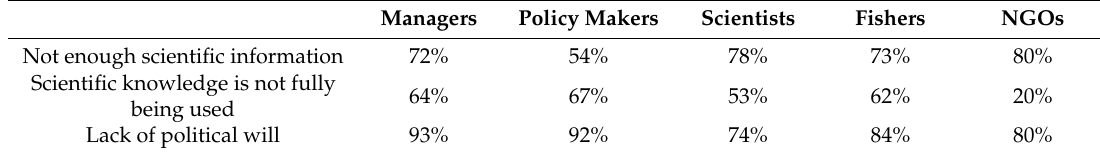
Table 4. Major reasons for why regulated fisheries are still faced with overexploitation.